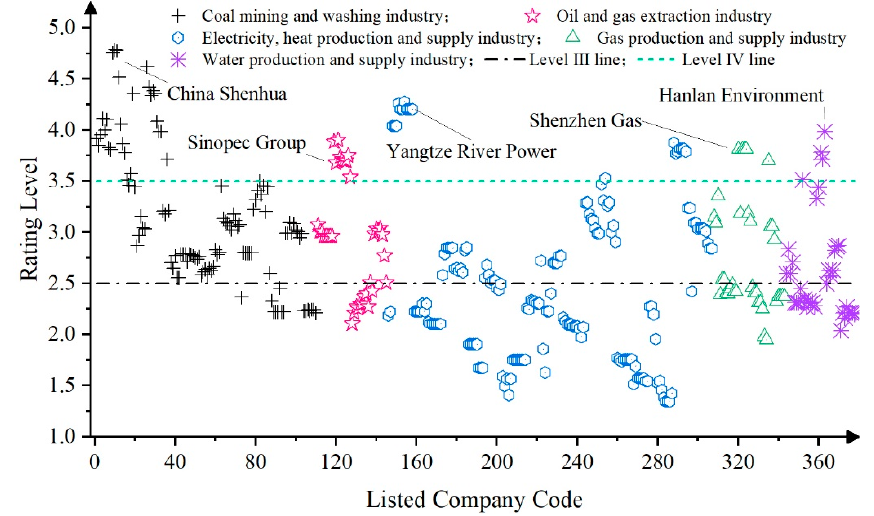
Figure 5. Comprehensive membership evaluation results of each company.